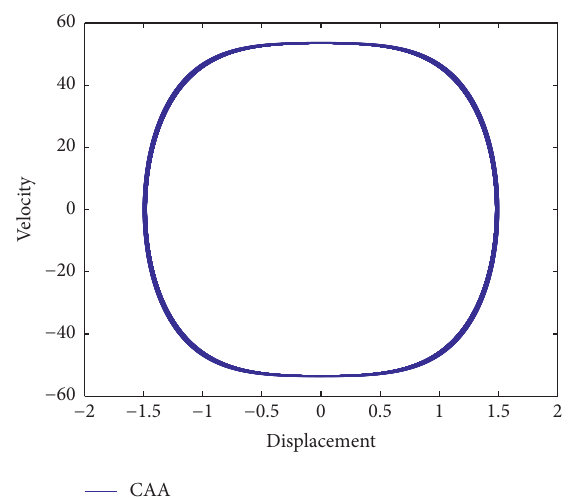
Figure 22: Phase portrait of the hardening spring calculated using the CAA method when Δ t � T /20.